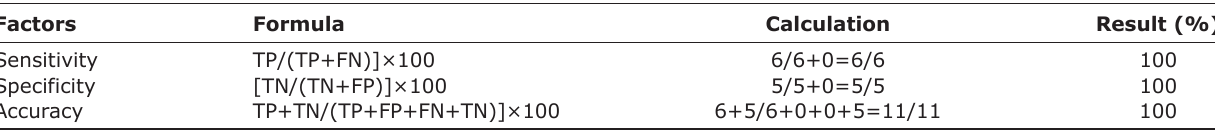
Table-4: Test results of HnRT-PCR. Factors